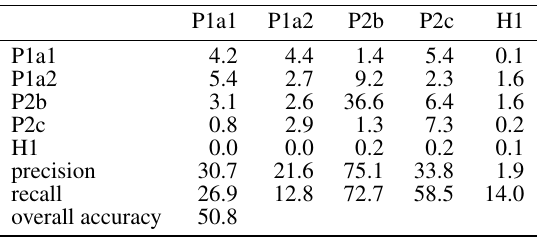
Table 1. Accuracy assessed with the sampling and validation scheme SSAC, on test tiles. Confusion matrix is normalised by the entire area. Precision, recall, and overall accuracy (%) are calculated using area-weighted accuracy assessment.